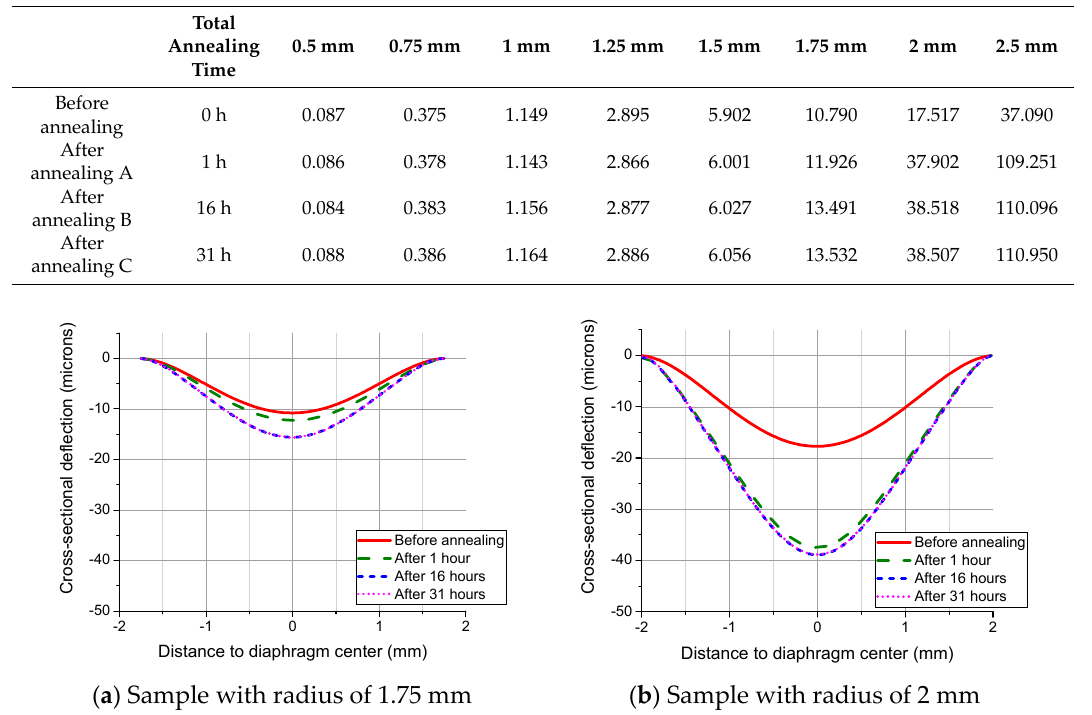
Figure 8. Surface profiles of SCS diaphragm cross-sections with a radius of ( a ) 1.75 mm and ( b ) 2 mm measured after the annealing processes at 800 °C.